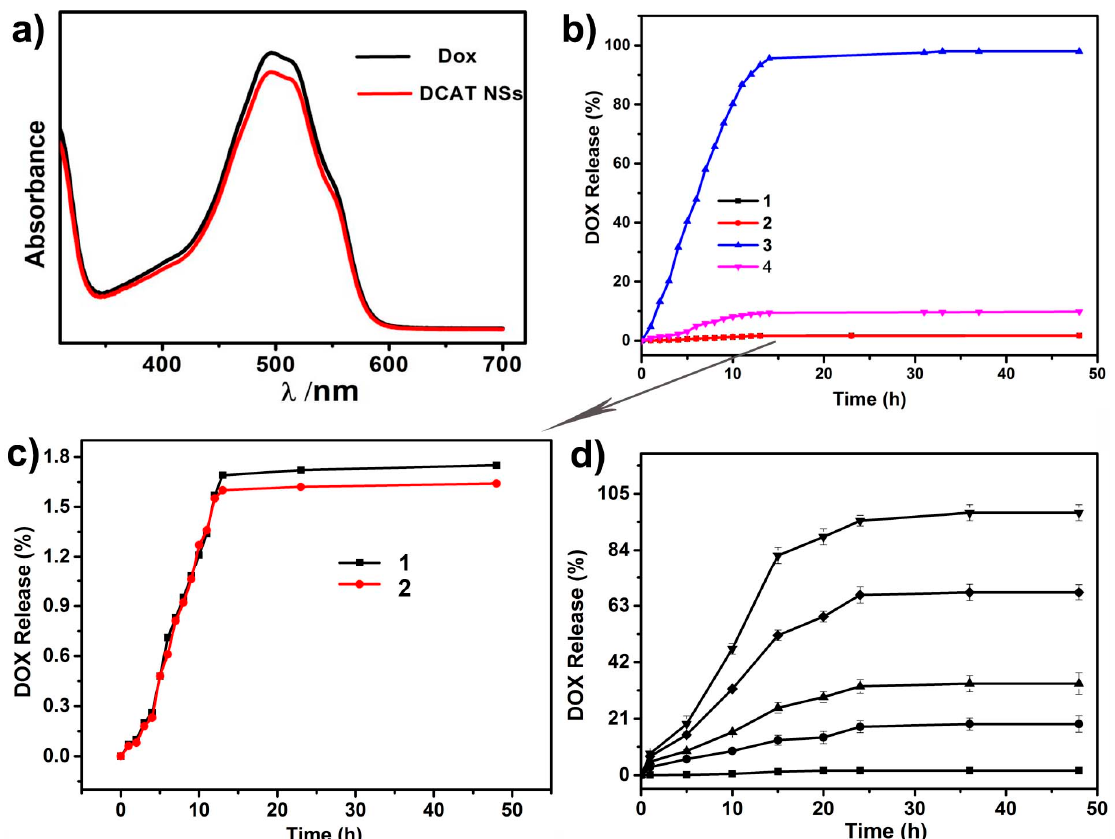
Figure 5. ( a ) UV-vis spectra of Dox and DCAT NSs; ( b ) release profiles of Dox from DCAT NSs at pH = 7.4 (1, 2) and 5.0 (3, 4), in the absence (2, 4) and presence (1, 3) of 4.2 mM GSH; ( c ) the magnified profiles 1 and 2 in ( b ); ( d ) GSH-dependent Dox release from DCATP NSs in the presence of different glutathione concentration at pH = 5.0.